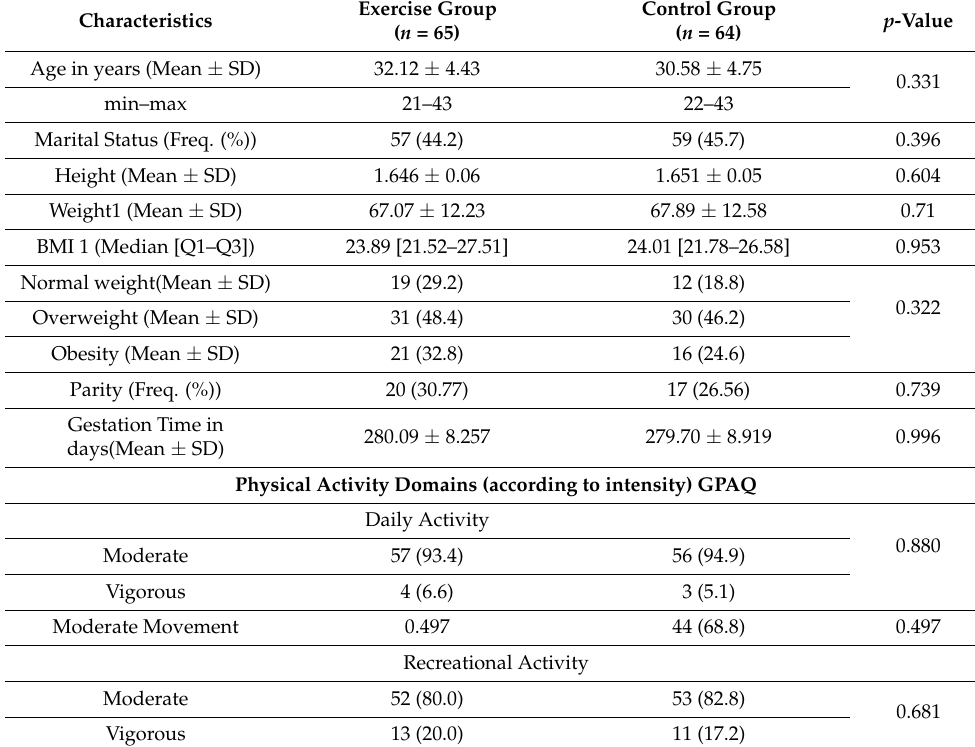
Table 1. Basal characteristics of the sample.